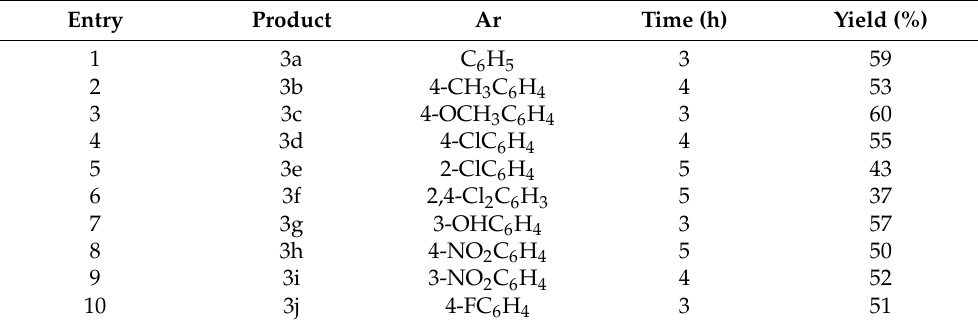
Table 1. Synthesis of benzo[6,7]chromeno[2,3- d ]pyrimidine derivatives under one-pot solvent- and catalyst-free conditions.